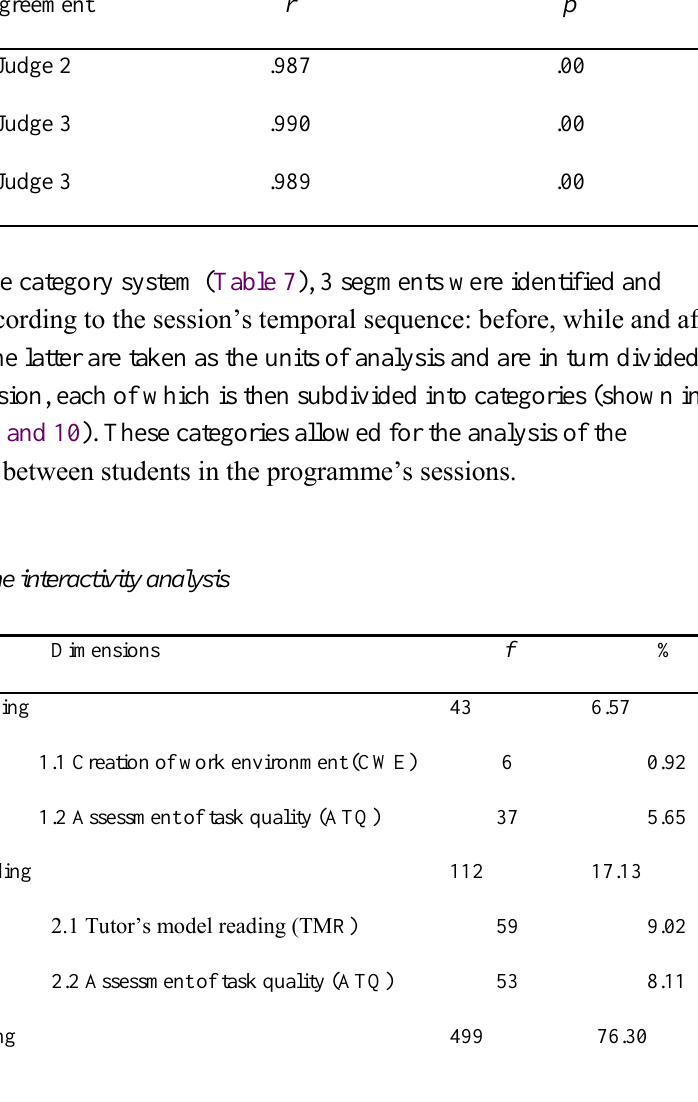
Reliability of the category system according to Pearson’s correlation coefficient Interjudge agreement